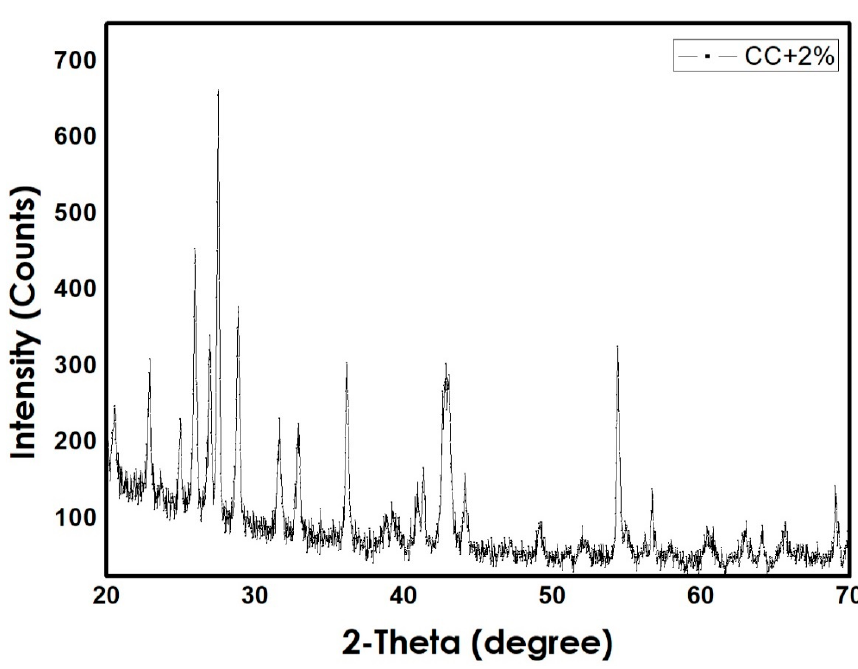
Figure 3. XRD pattern for CC + 2% Fe 3 O 4 composite.